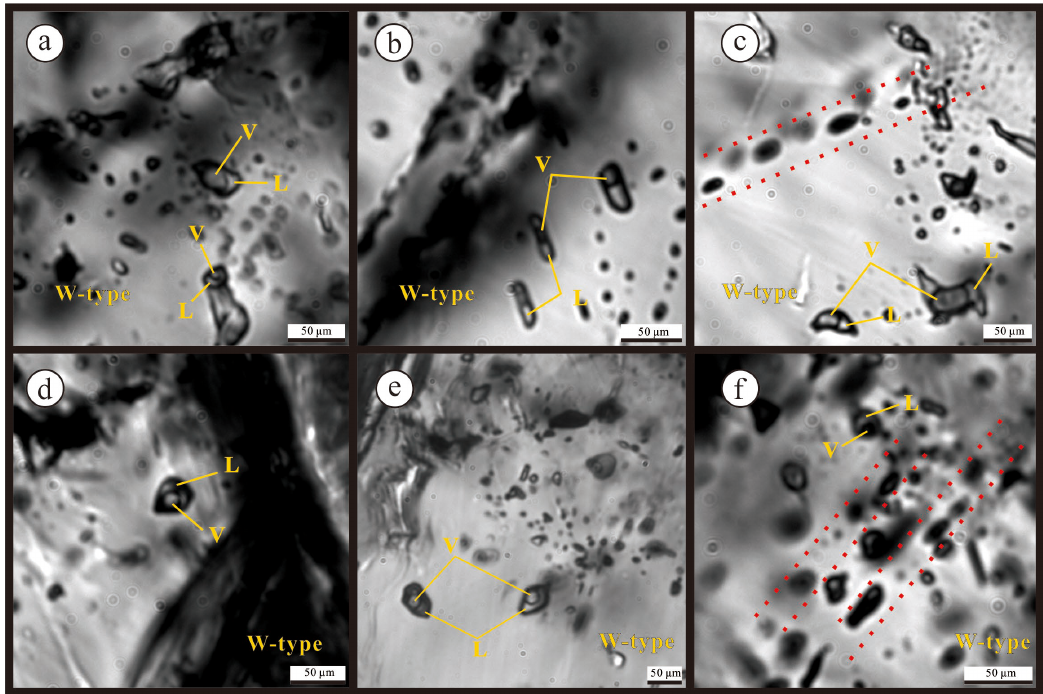
Figure 6. Infrared micrographs of fluid inclusions in wolframite from the Hongqiling Sn-W polymetallic deposit: ( a , e ) coexistence of W-type inclusions with different phase ratios; ( b ) combination of W-type inclusions distributed along a fissure; ( c , f ) combination of W-type inclusions distributed along the growth annulus and vapor-rich W-type inclusions; ( d ) isolated W-type inclusions.